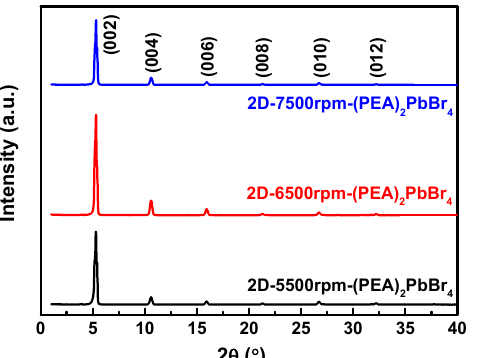
Figure 8. X-ray diffraction (XRD) patterns of 2D-(PEA) 2 PbBr 4 films formed with different spin speeds.